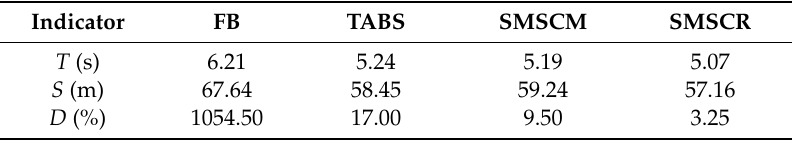
Figure 6. Simulation results of four emergency braking control strategies mentioned in Section 4.1 on muddy ground. They are the curves of vehicle and track speed, slip ratio and braking torque of: ( a ) full braking (FB); ( b ) traditional ABS (TABS); ( c ) sliding mode slip control without motor (SMSCM); ( d ) sliding mode slip control with regenerative braking (SMSCR). VV, TV, HRT, MBT, and MRT are vehicle velocity, track velocity, hydraulic retarder torque, mechanical brake torque, and motor regenerative torque, respectively. Table 2. The value of indicators in the simulations on a muddy